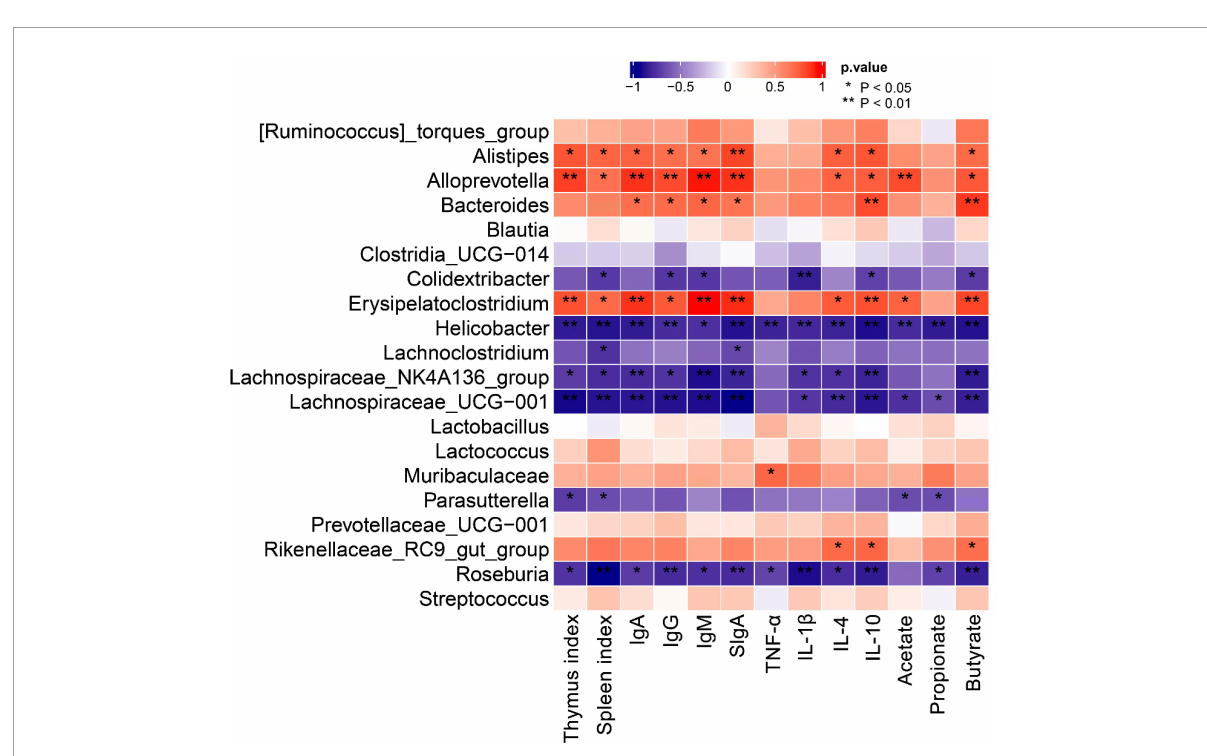
FIGURE8 Spearman correlation between genus level communities with the top 20 abundances and immune-related indexes (** P < 0.01, * P <